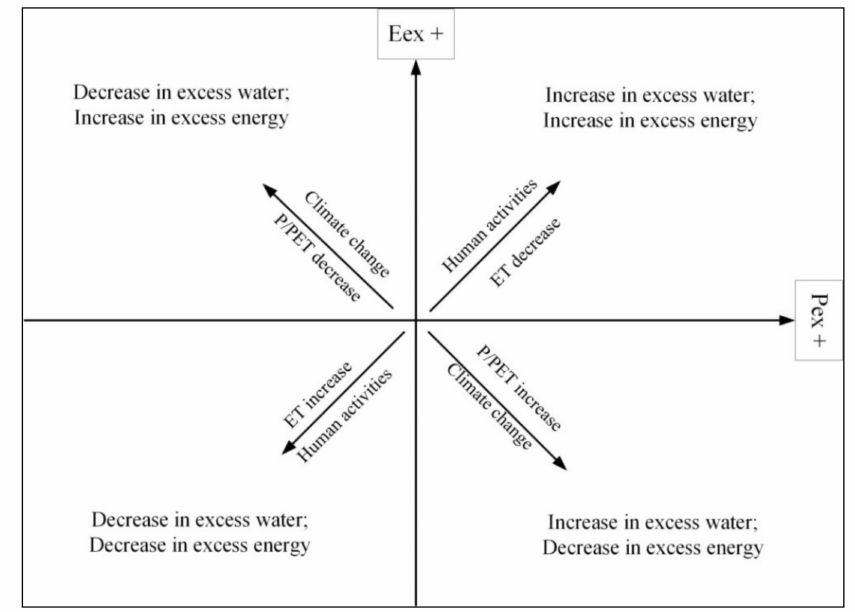
Figure 4. Tomer Schilling